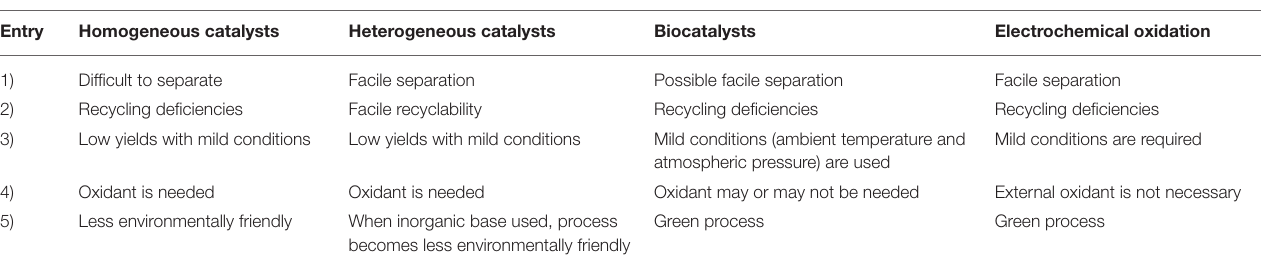
TABLE 1 | Summary of the different HMF oxidation processes to